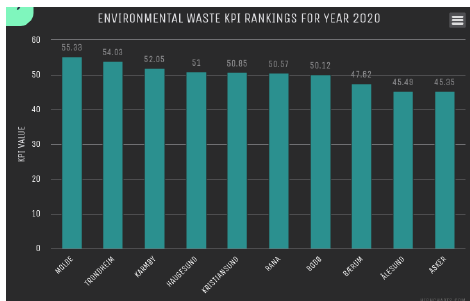
Figure 8. Environmental waste for all cities in 2020.